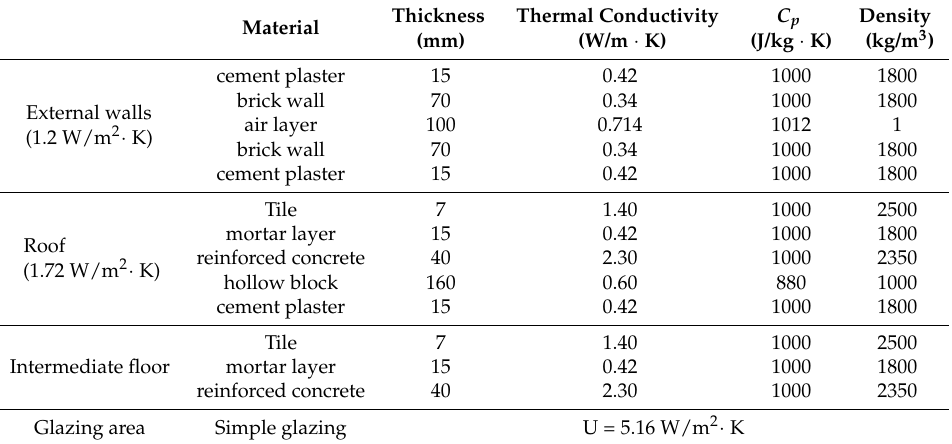
Table 5. Reference residential building: initial constructive characteristics—Scenario